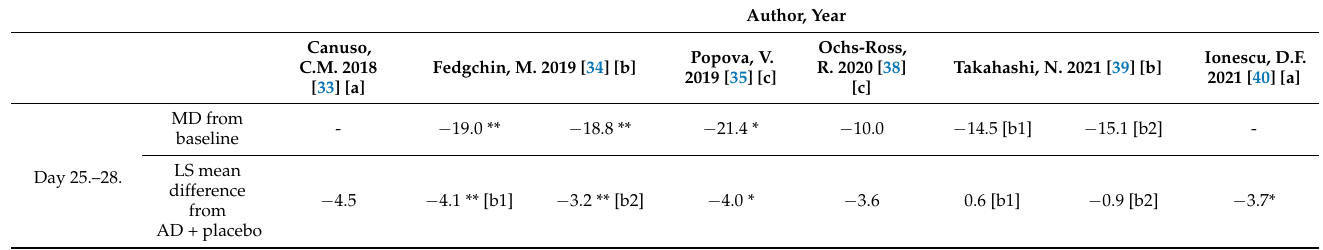
Table 3. Change in MADRS score at 25th-28th day of esketamine